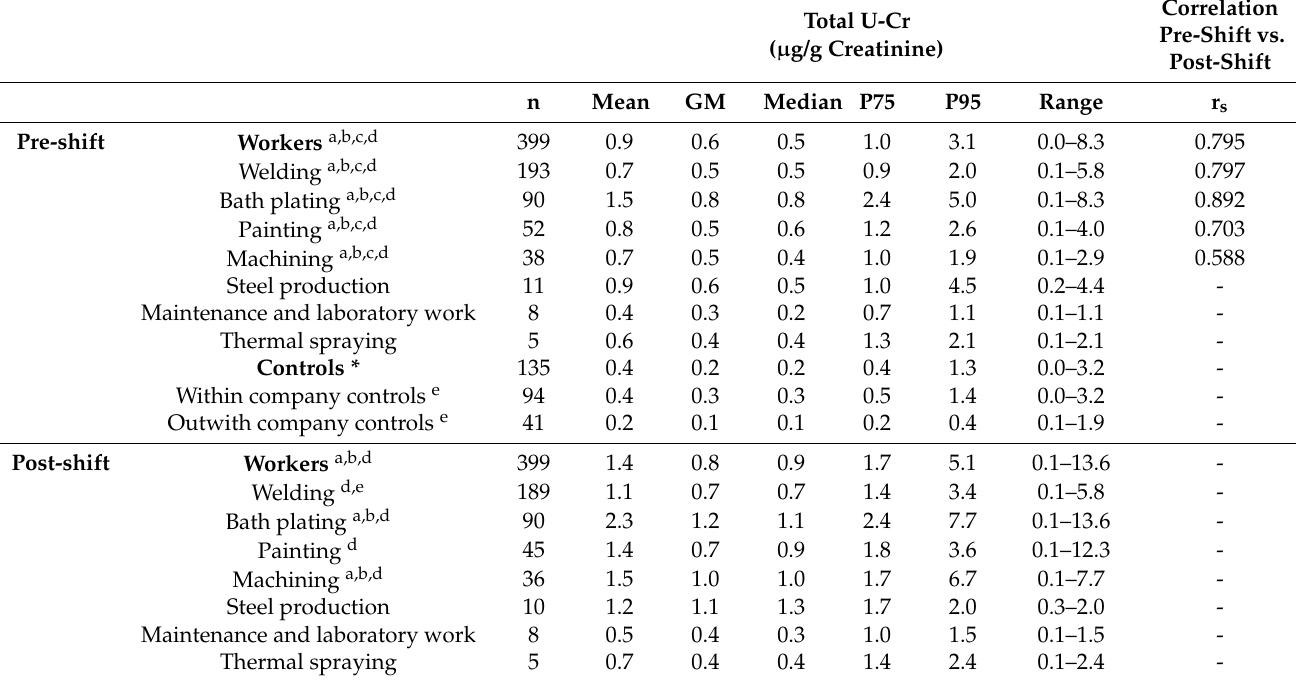
Table 3. Urinary concentrations of total Cr in the population of workers studied and compared with controls. Results are adjusted for